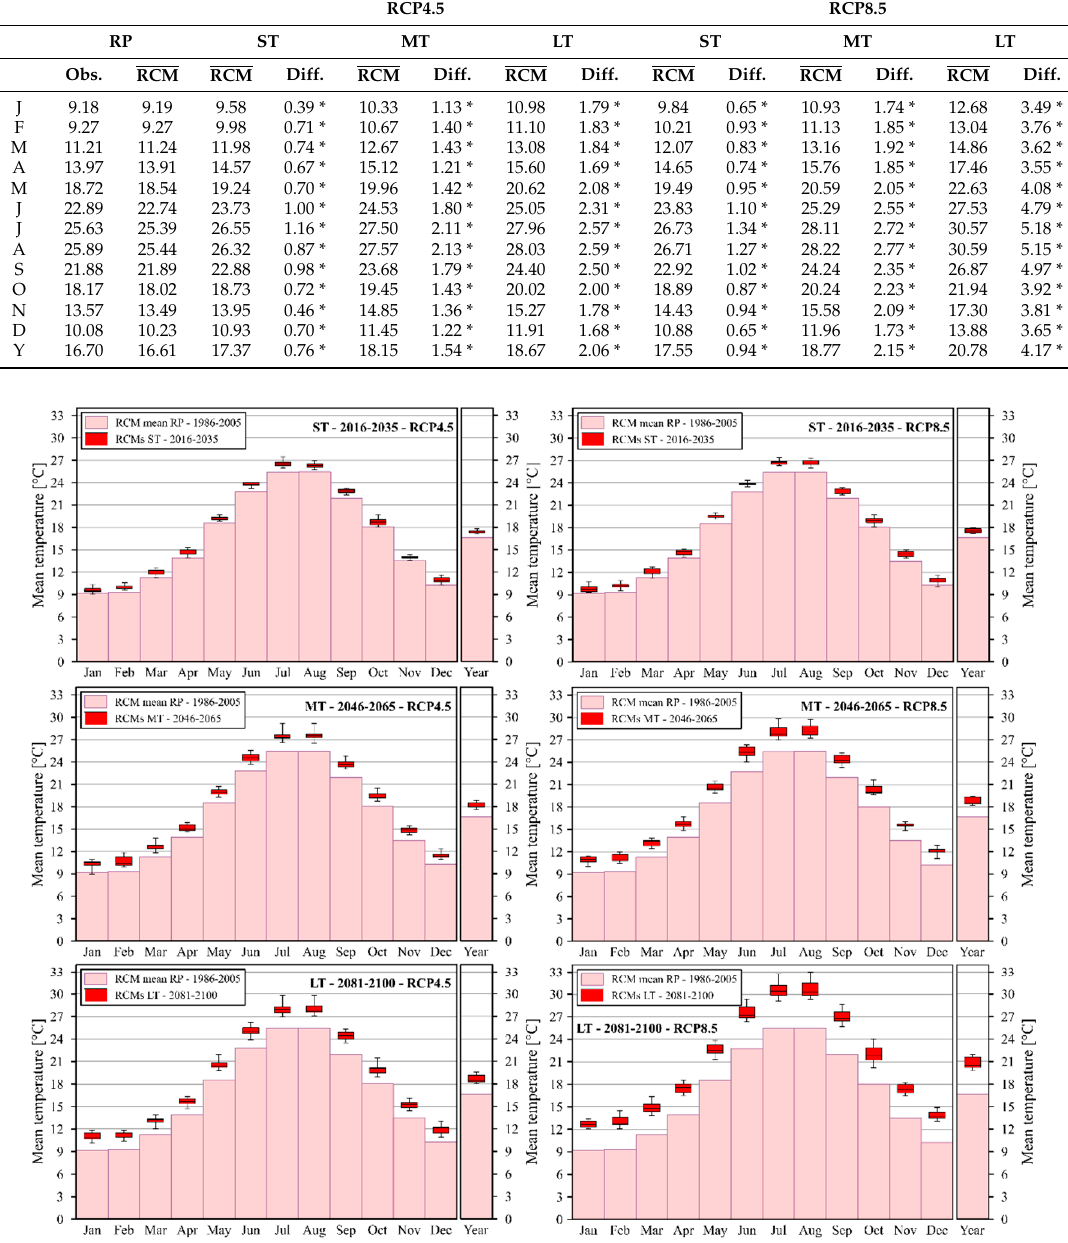
Figure 9. Monthly and annual mean temperature, over the Salento area, evaluated by the RCMs at the short—(ST), medium—(MT) and long-term (LT) under the RCP4.5 and RCP8.5 scenarios. The box-whisker plots represent the variability between the 13 RCMs (the whiskers indicate the minimum and maximum values). Bars of the RCM ensemble mean in the reference period (RP).